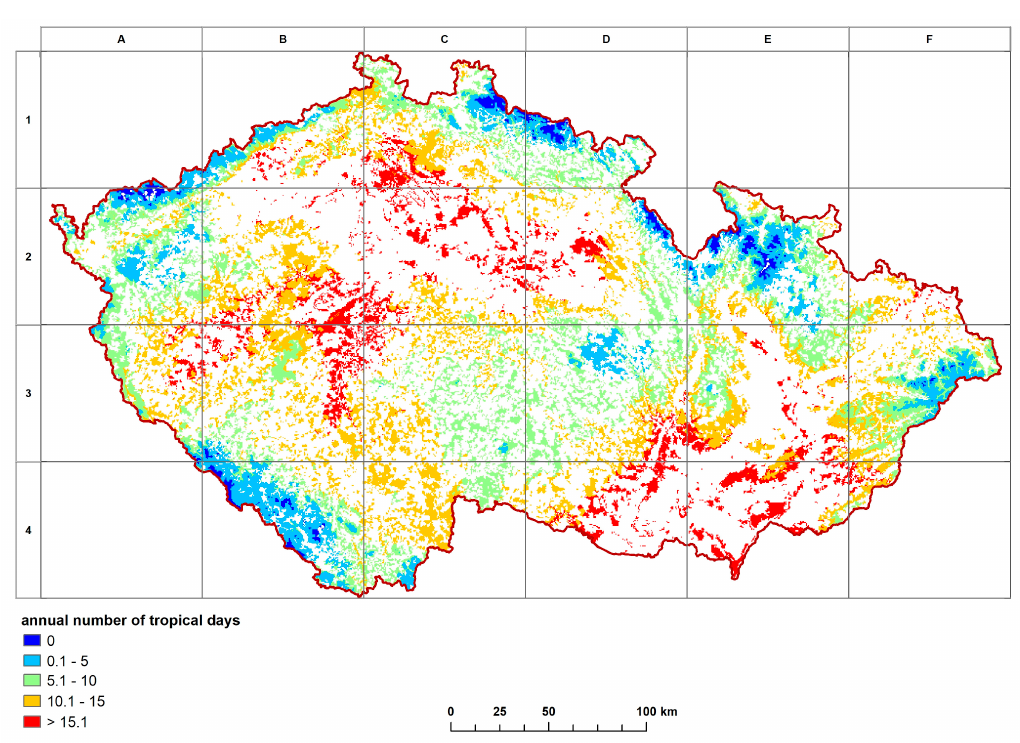
Figure 3. Categories of high temperature (HT) risk based on long-term annual number of tropical days (TDs). Table 8. Overview of threat categories, their weights, and range of relevant